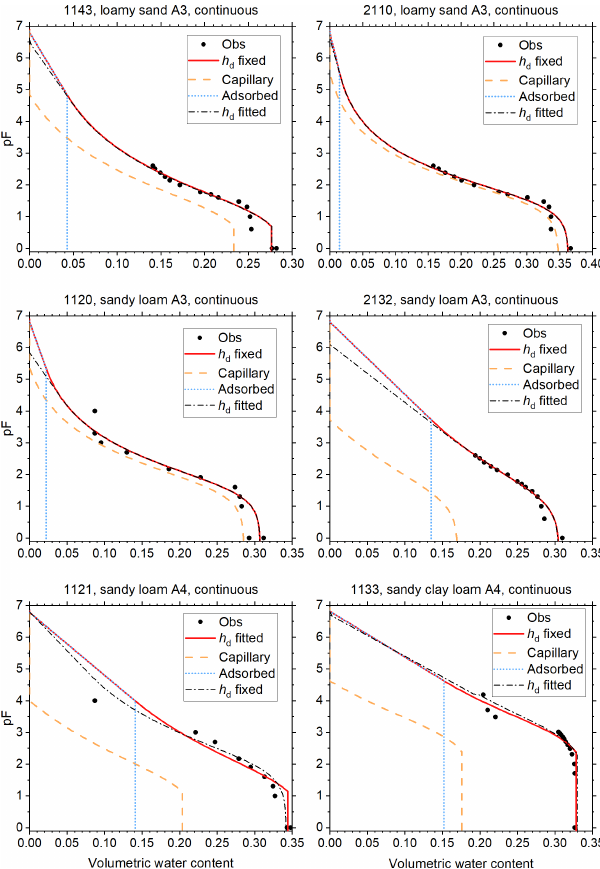
Figure 6. As Fig. 5, for soils of classes A3 and A4 of Twarakavi et al.